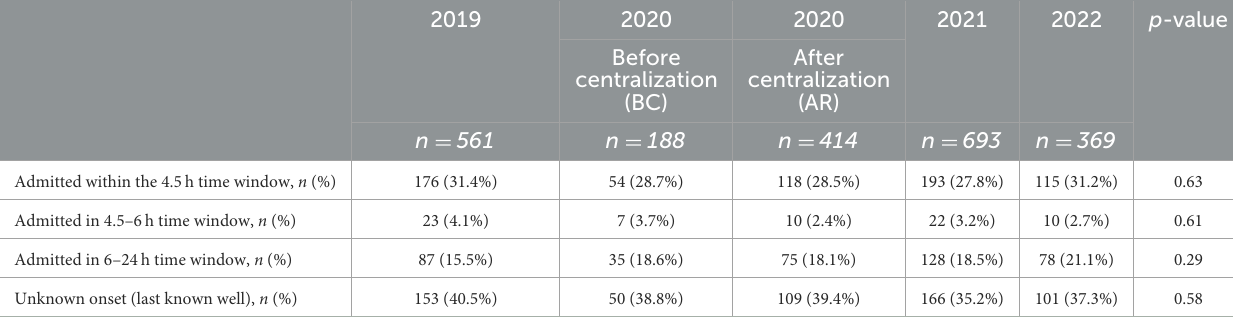
TABLE 3 Onset to admission time in patients treated with reperfusion therapy treatment stratified by year.